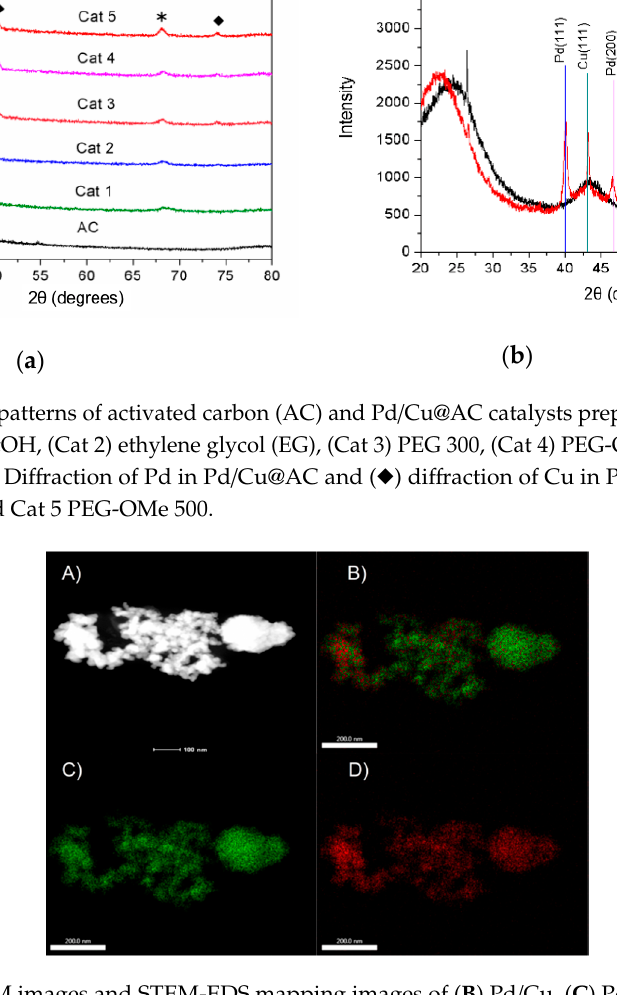
Figure 4. Core–shell XPS spectra of ( A ) Pd 3d and ( B ) Cu 2p . The activity of Pd/Cu@AC catalysts was evaluated for Sonogashira coupling. Initially, 4- iodotoluene and phenylacetylene were selected for the model reaction to test the activity of Cat 1– Cat 5. As shown in Table 1, Cat 1 prepared using EtOH provided an 87% yield, whereas Cat 2 provided less yield (80%) even though an XRD peak for Cu was clearly observed in Figure 1. This indicates that Pd had a major influence on the bimetallic catalysts of Sonogashira cross-coupling reactions. Furthermore, the activity of catalysts produced by polymeric solvents was better than other catalysts. The activities of solvothermally prepared monometallic catalysts, Pd@AC and Cu@AC (both produced in PEG-OMe 500), were also evaluated. They afforded products in 50% and 61% yields, respectively, much less than Pd/Cu@AC (up to 98% yield). The controlled experiments with mixtures of Pd@Ac and Cu@Ac as catalysts afforded a 67% yield, showing the superior activity of heterometallic catalysts. These results clearly indicate that the cooperative catalysis of Pd and Cu was essential to achieve a significant improvement in catalytic Csp2–Csp coupling reactions. The best result was obtained in the presence of Cat 5, 2 equiv of K 2 CO 3 , and 5 mol% of PPh 3 in EtOH and N2 atmosphere at 80 °C for 12 h. Therefore, PEG-OMe 500 is an ideal solvent for the preparation of active Pd/Cu@AC catalysts, providing the highest crystallization of both Pd and Cu.